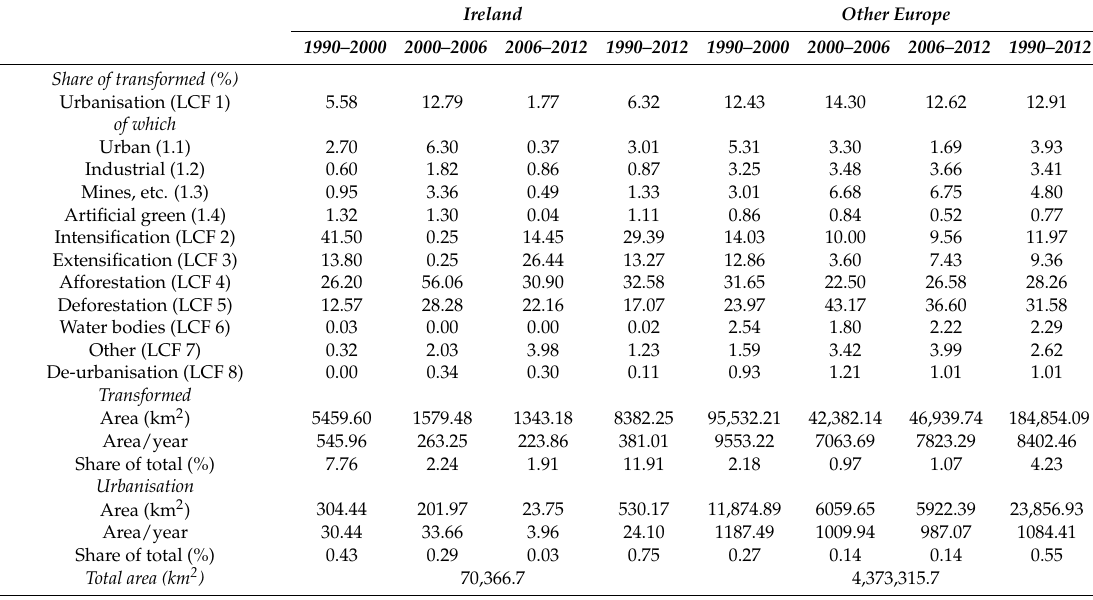
Table 4. Land conversion in Ireland and other European countries over 1990–2012. Ireland Other Europe Share of transformed (%) Urbanisation (LCF